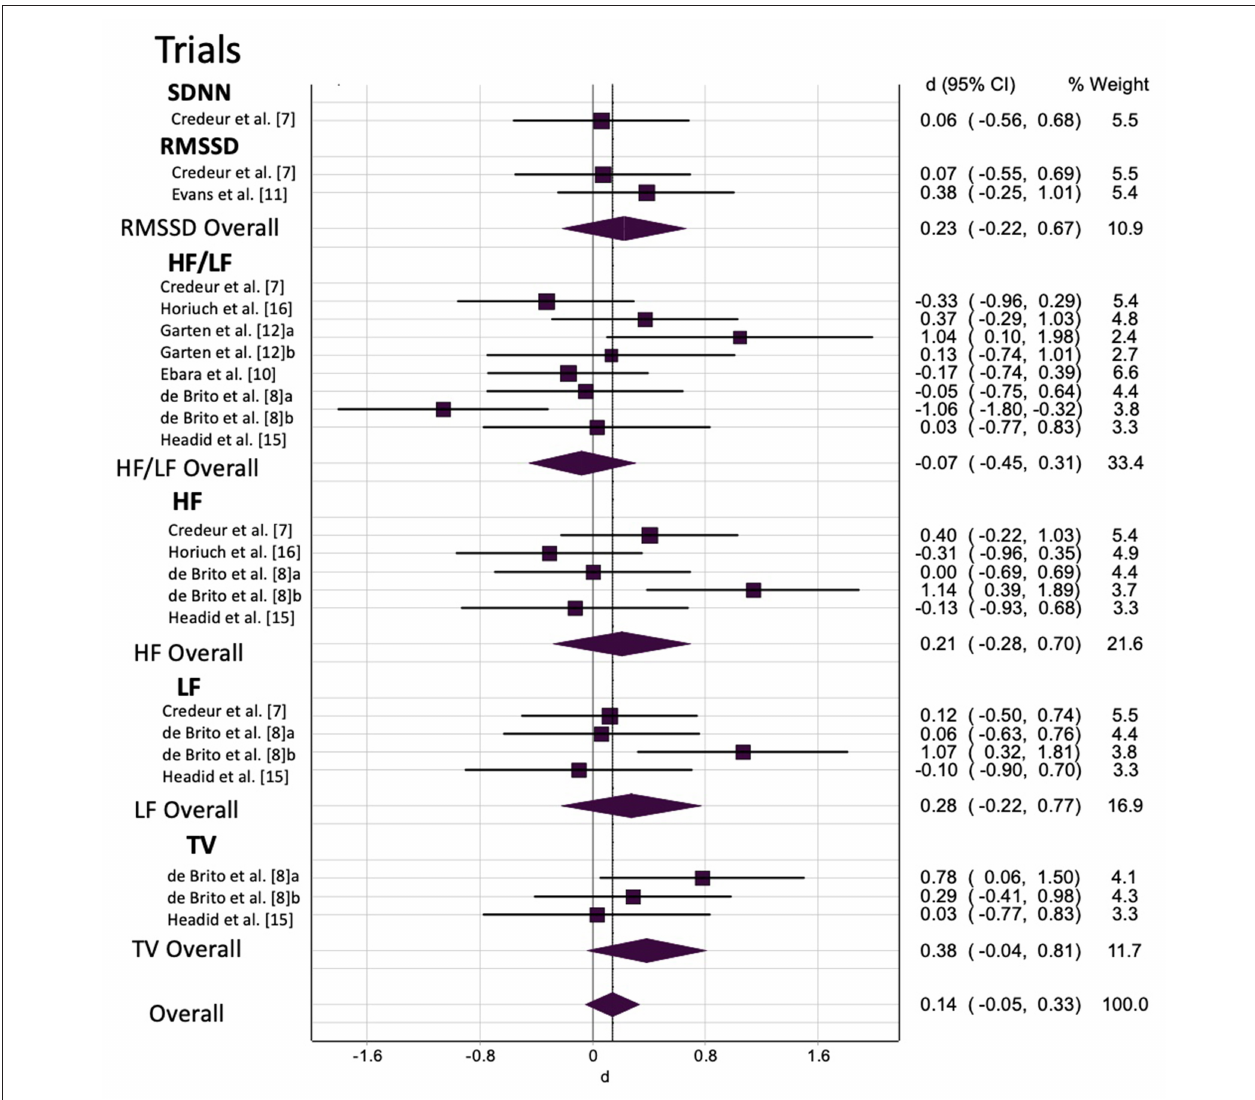
FIGURE 3 | The effect of prolonged sitting on heart rate variability by outcome measure. a/b, multiple trials within the same study; SDNN, standard deviation of NN intervals; RMSSD, root mean of successive difference; HF, high frequency; LF, low frequency; HF/LF, high frequency/low frequency ratio; TV, total variance; WMD, weighted mean difference; CI, confidence